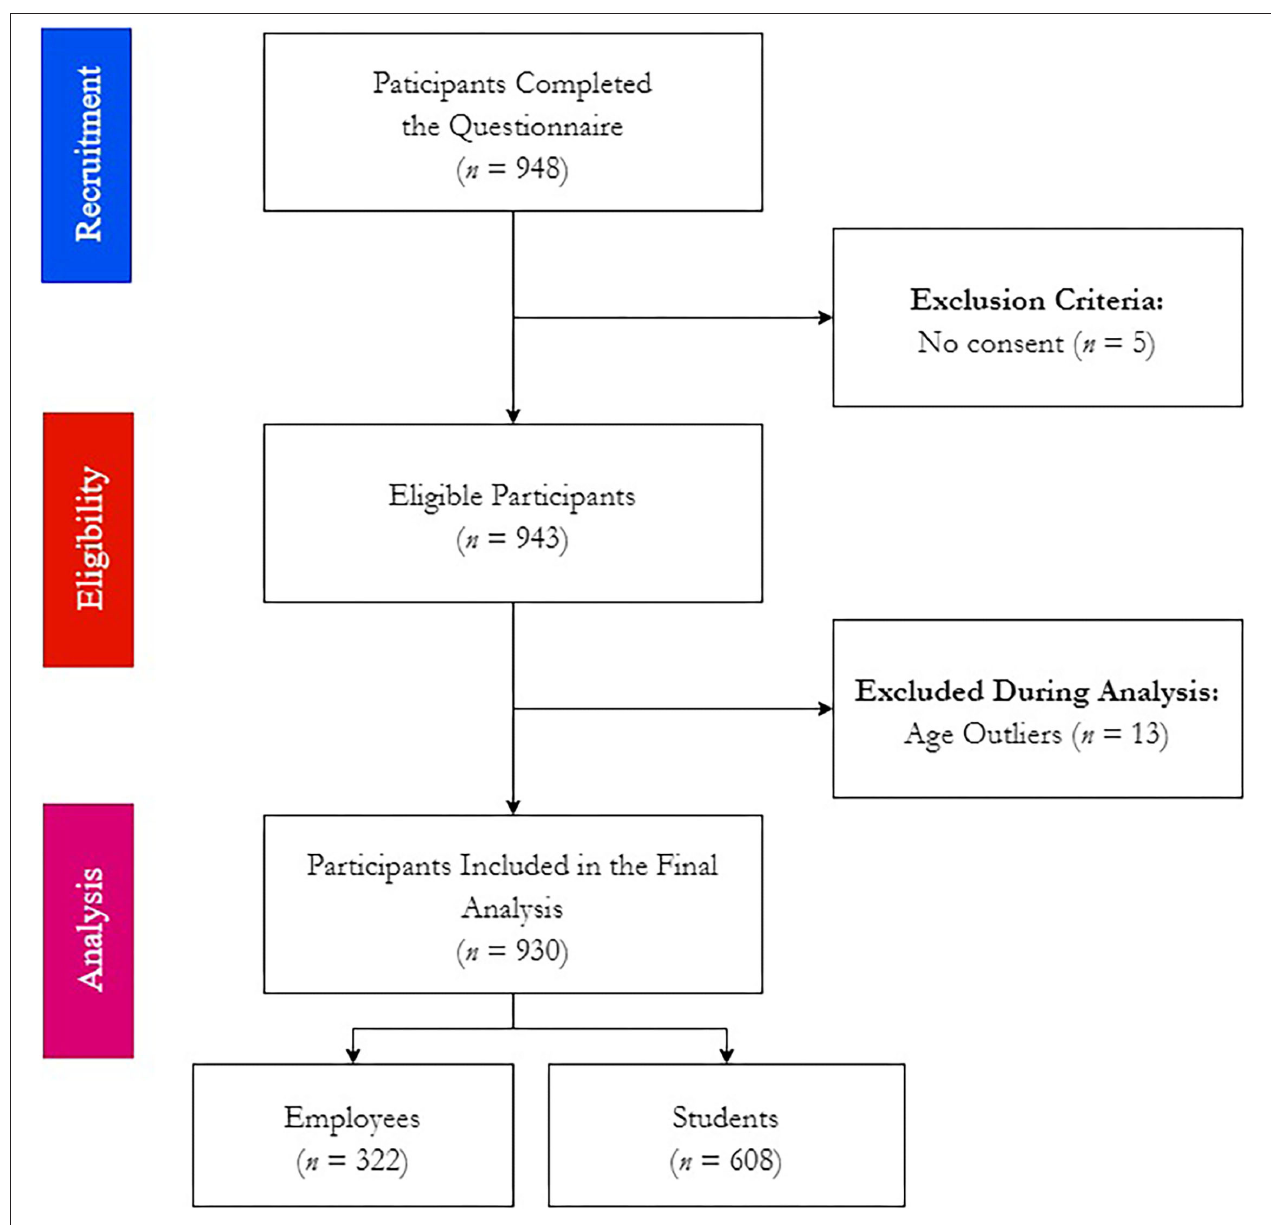
FIGURE 2 | Workflow of COVID-19 Vaccine Booster Hesitancy (VBH) Survey among German university students and employees, december 2021 ( n =